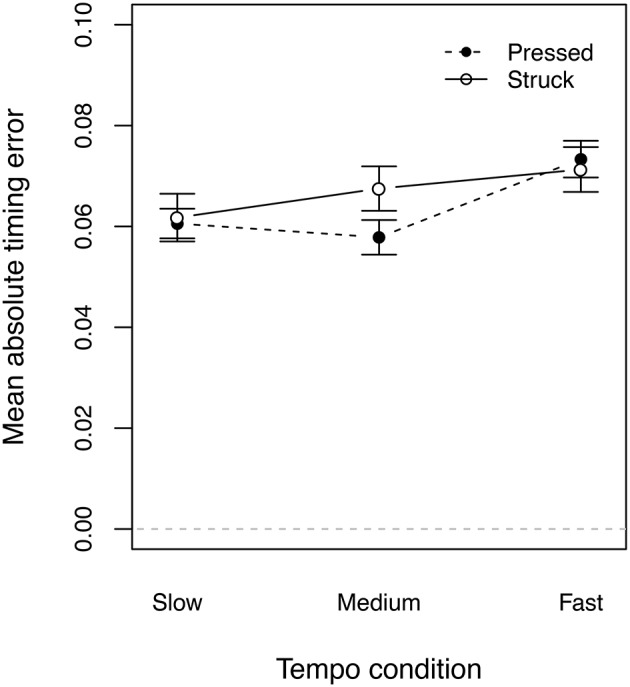
Absolute timing error of successive note onsets, grouped by the touch type of the preceding note and the three tempo conditions of the technical exercise task.